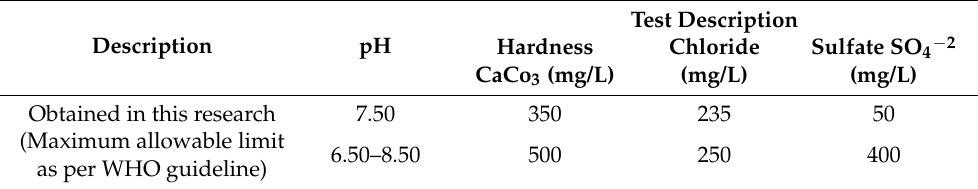
Table 5. Characteristics of mixing water.